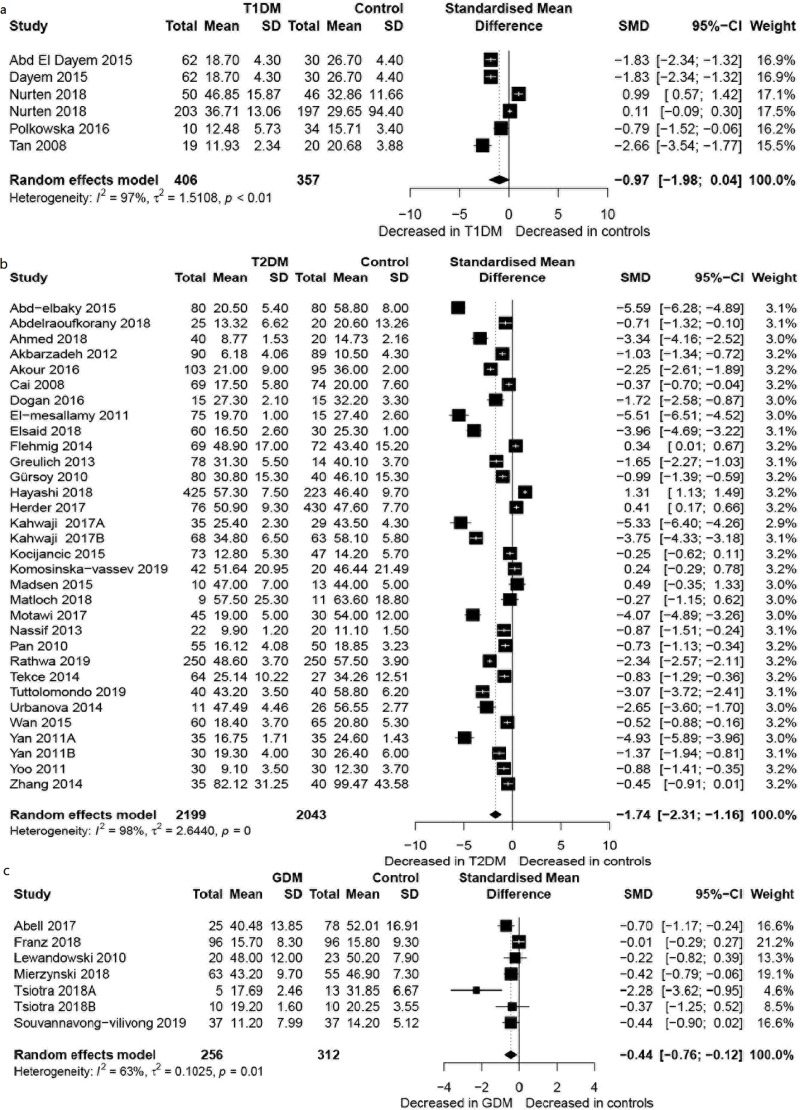
Forest plot of gestational diabetes mellitus (a), type 1 diabetes mellitus (b) and type 2 diabetes mellitus (c). Study effect sizes of omentin-1 concentration differences between diabetes mellitus and controls. Each data marker represents a study, and the size of the data marker is proportional to the total number of individuals in that study. The summary effect size for each omentin-1 concentration is denoted by a diamond. T1DM, type 1 diabetes mellitus; T2DM, type 2 diabetes mellitus; GDM, gestational diabetes mellitus; SMD, standardized mean difference.